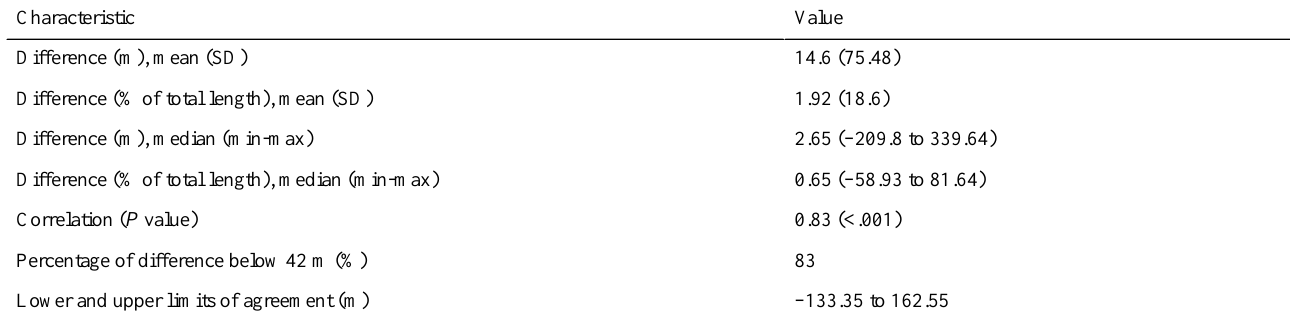
Table 1. Differences between a 6-minute walk test distance (6MWD) measured by physiologist and simultaneous 6MWD measured by the app in indoor